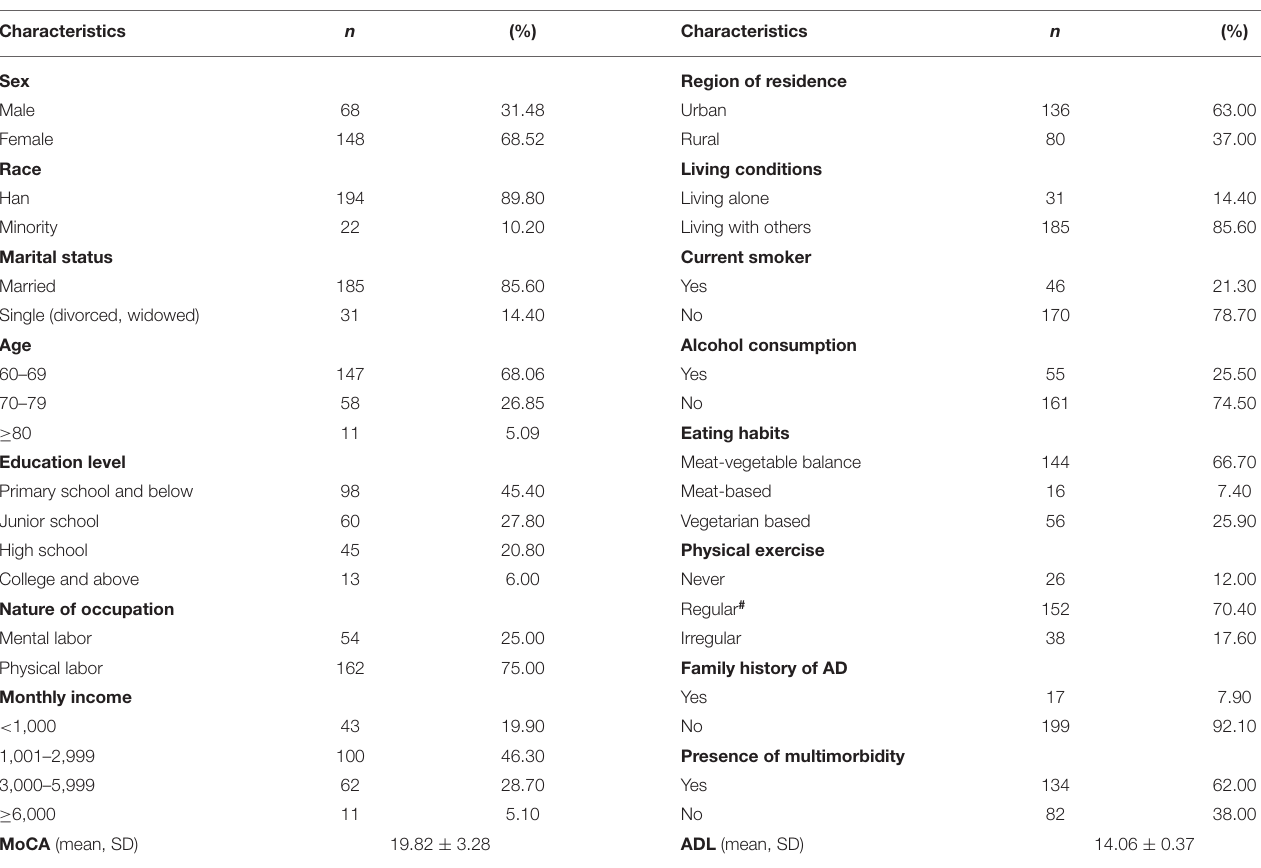
TABLE 1 | Characteristics of the study participants ( N =